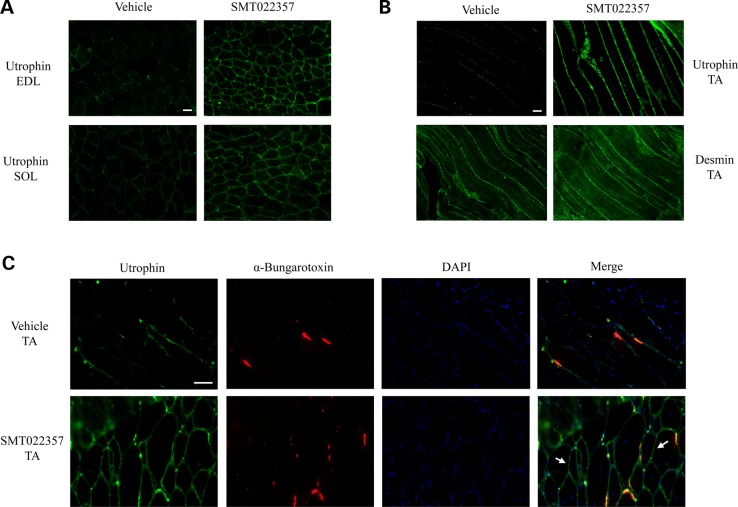
SMT022357 increases utrophin expression in skeletal muscles. (A) Immunofluoresence staining for utrophin in EDL and SOL muscles of 7 weeks old mdx mice treated for 5 weeks with 30 mg/kg/day SMT022357 or vehicle. Transverse sections were stained with anti-utrophin polyclonal antibody URD40 and anti-rabbit secondary antibody. Scale bar: 100 µm. (B) Longitudinal cryosections of TA muscle following treatment of mdx mice homogenously increased the utrophin expression along the myofiber after treatment with SMT022357 compared to vehicle group. Scale bar: 100 µm. (C) Co-immunohistochemical staining of TA muscle with utrophin, α-Bungarotoxin and DAPI prepared from mdx mice treated with SMT022357. White arrows indicate utrophin expression in extra-synaptic regions of the sarcolemma. Scale bar: 50 µm.